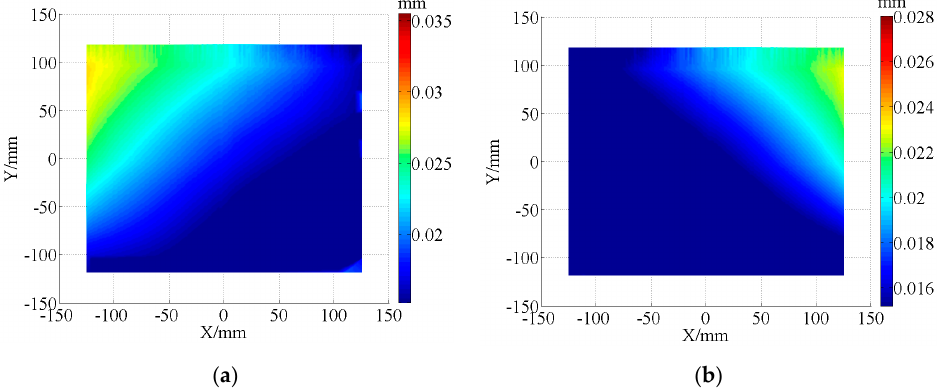
Figure 7. Error distribution by contacted scanning method. ( a ) Error distribution of concave surface 1; ( b ) Error distribution of convex surface 1.